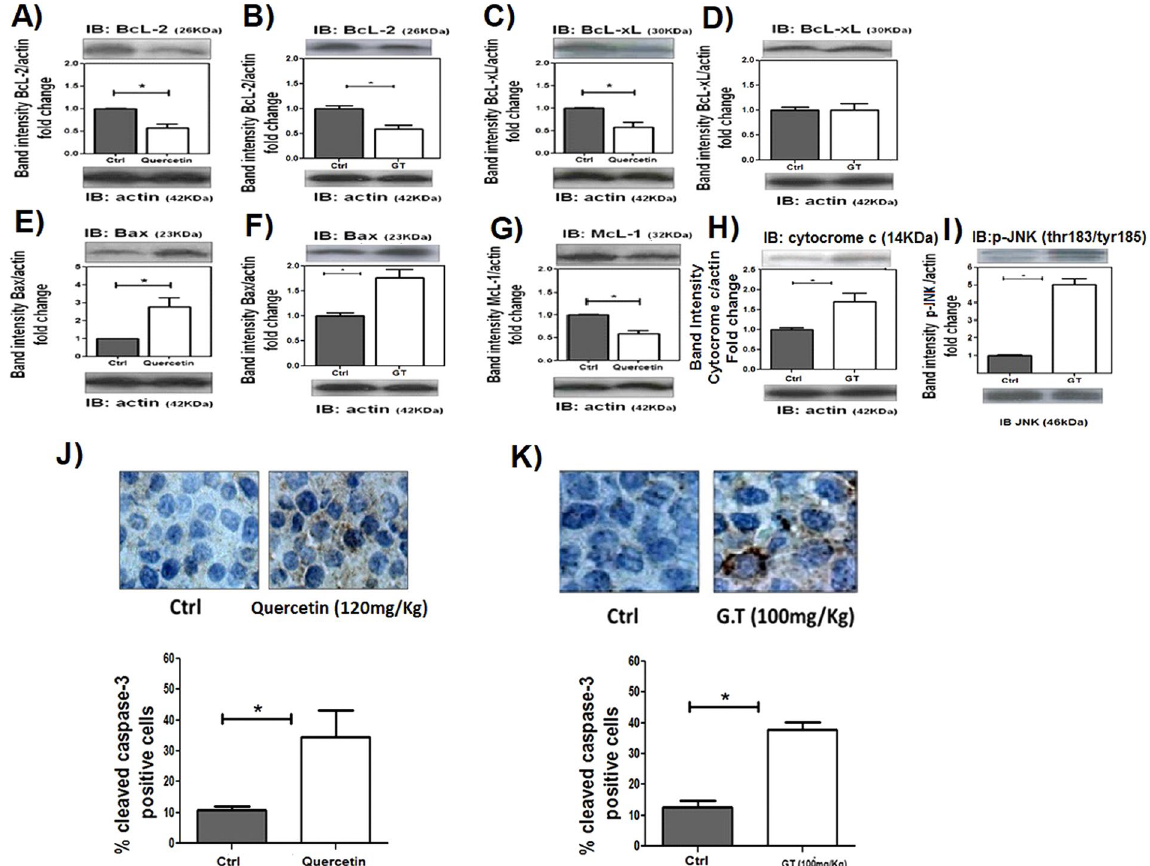
Figure 2. Quercetin and Green tea induces apoptosis of leukemic cells. NOD/SCID mice with HL60 tumors were treated or not with quercetin (120 mg/kg), once every 4 days or green tea (100 mg/kg), every day. After 3 weeks, tumors were harvested and relative levels of protein in tumor lysates were determined by Western blotting ( A , B ) BCL-2; ( C , D ) BCL-XL; ( E , F ) BAX; ( G) -MCL-1; ( H) - cytocrome c; ( I) - p-JNK. ( J , K ) IHC analysis of cleaved caspase-3 in tumor sections and the percentage of caspase 3 positive nuclei of cells per field; four fields per tumor section. Counts were made using x40 objective connected to a light microscope (Olympus CBA; Olympus America). Values are means ± SD (mean of 6 mice/group); * P <